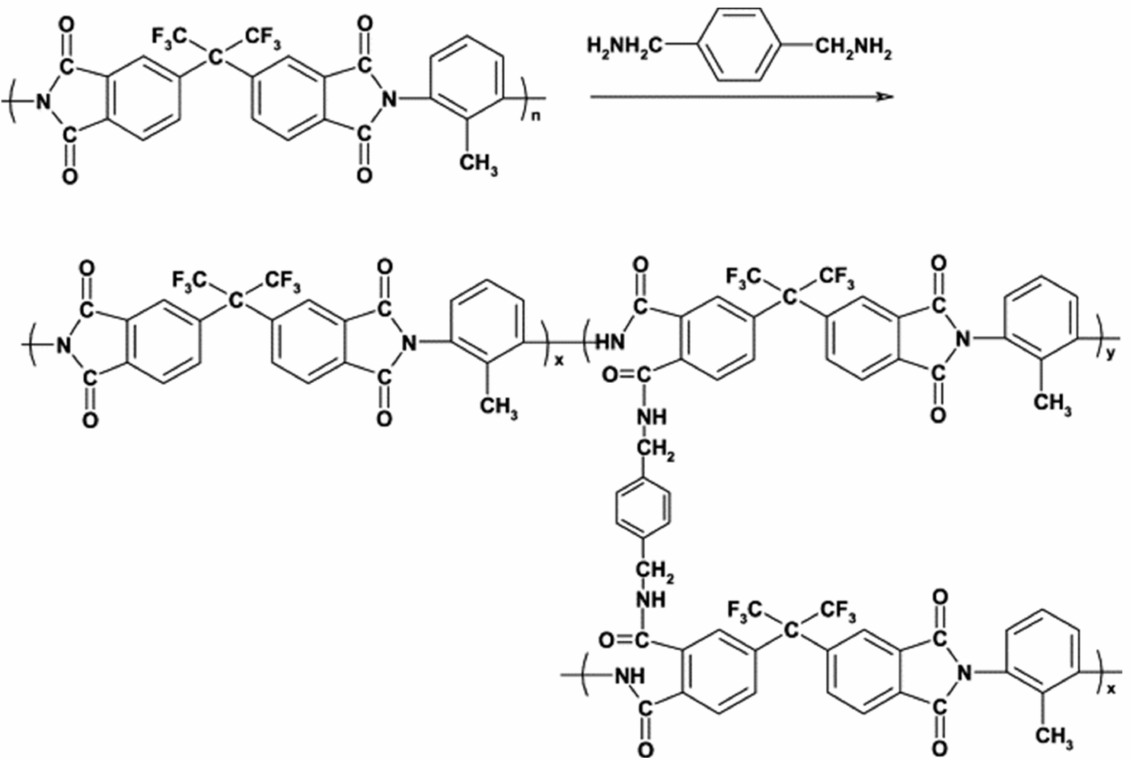
Figure 11. The mechanism of crosslinking between amines and PI. Reprinted with permission from Ref. [93]. Copyright 2003,